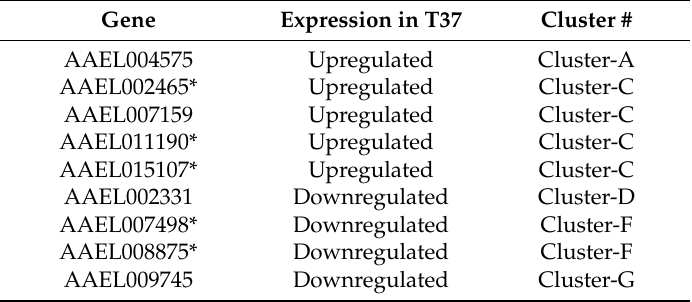
Table 4. List of DEGs related to Kyoto Encyclopedia of Genes and Genomes (KEGG) metabolic pathways. The expression pattern of these genes in T37 testes and their association with predicted expression clusters are shown. The genes with asterisks map to the specific metabolic pathway